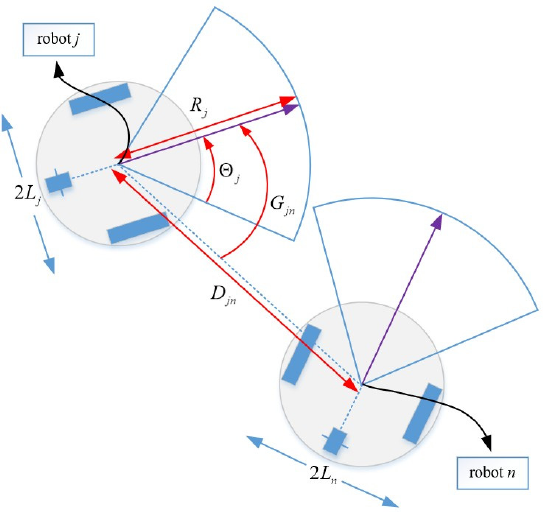
Figure 8. The sectors in front of the robots (the purple arrow denotes the moving direction of the robot).